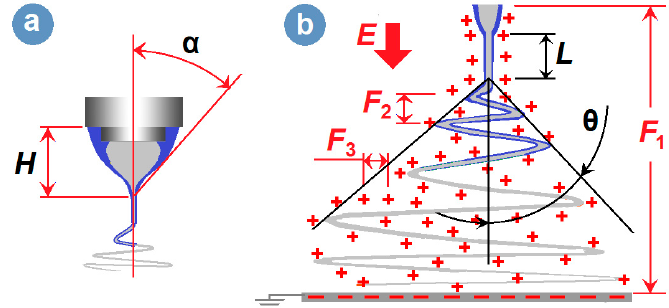
Figure 10. A diagram showing the typical three steps of the modified coaxial process: ( a ) The Taylor cone, ( b ) The straight fluid jet and instable region.